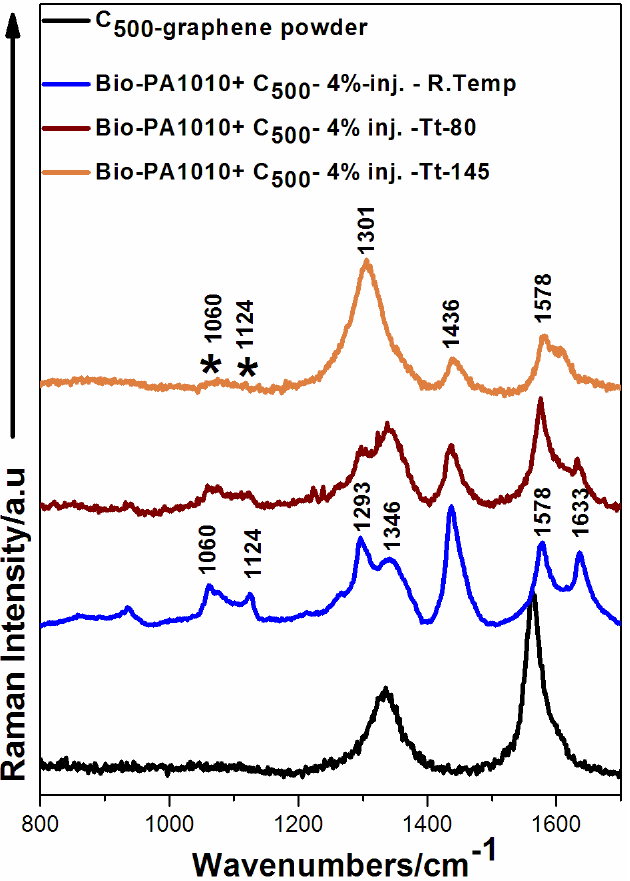
Figure 10. The Raman spectra of bio-PA1010 nanocomposite filled with GNP C500-4% thermally treated at 80 °C and 145 °C. We marked with * the bands that are less visible after the thermal treat ‐ ment.